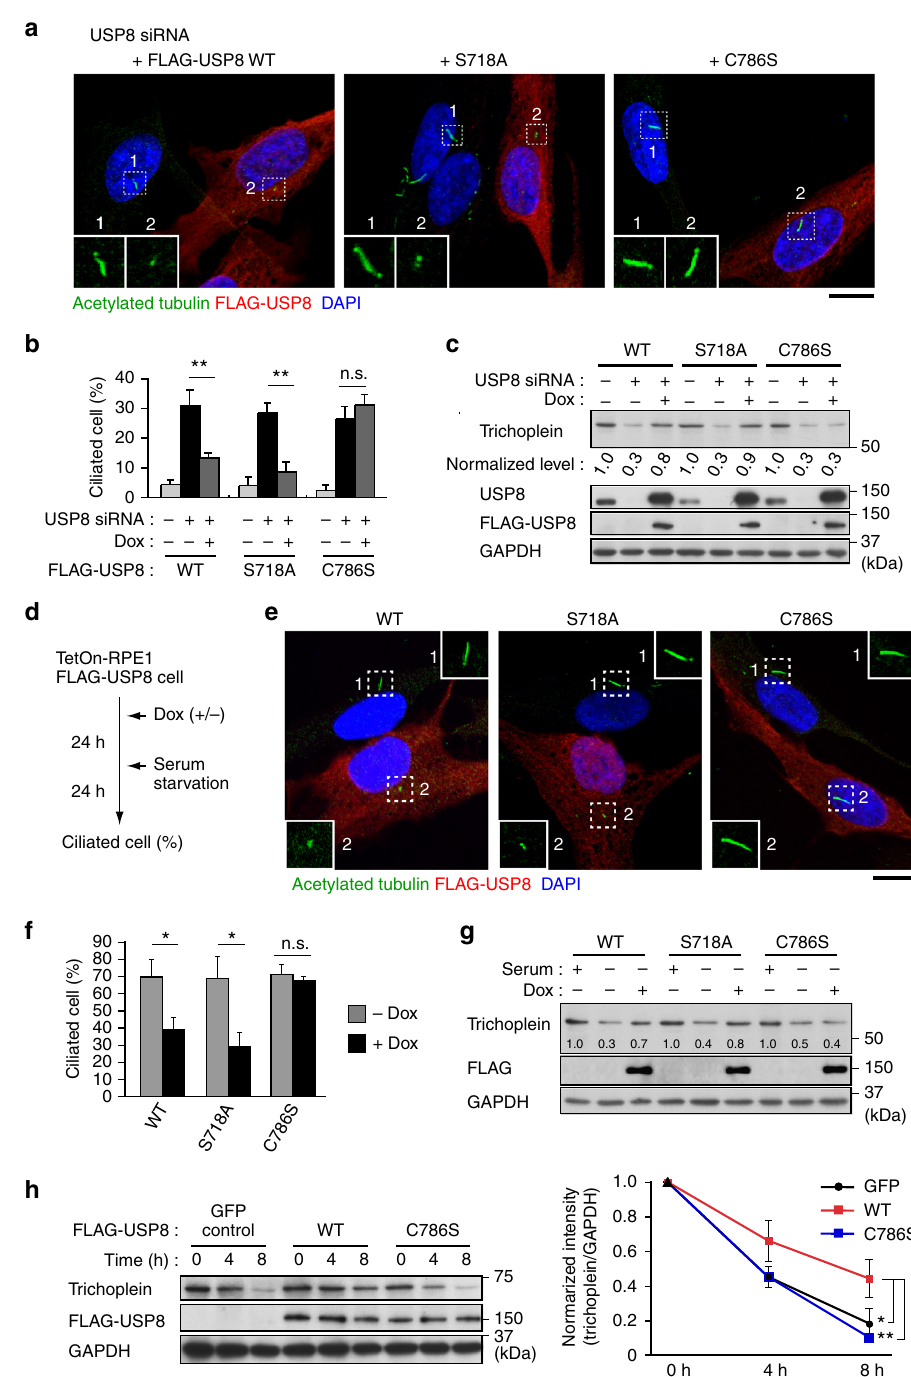
Fig. 2 USP8 activity is essential for suppression of ciliogenesis and stabilization of trichoplein protein. a – c TetOn-RPE1 FLAG-USP8 cell lines (WT, S718A, and C786S) transfected with control or USP8 siRNA (#1) were cultured for 48 h in the presence or absence of doxycycline (Dox, 100 ng ml − 1 ). d – g Expression of FLAG-USP8 (WT, S718A, and C786S) was induced by treatment with Dox (100 ng ml − 1 ), and then subjected to serum starvation as shown in d . Representative confocal images of anti-acetylated-tubulin (green), anti-FLAG (red), and DAPI (blue) are shown in a and e . Insets are magni fi ed images of dashed squares. Scale bars, 10 μ m. Percentages of ciliated cells are shown as mean ± SD from three independent biological replicates ( n > 200 each) in b and f . Immunoblotting analysis of trichoplein, USP8, FLAG and GAPDH are shown in c and g . Normalized intensities of trichoplein/GAPDH are shown as mean from three independent biological replicates. h FLAG-USP8 (WT or C786S) or GFP (as a control) were expressed by treatment with Dox (100 ng ml − 1 ) in TetOn-RPE1 cells, and the cells were treated with 200 nM cycloheximde-supplemented serum-starved medium for indicated times. Normalized intensities of trichoplein/GAPDH are shown as mean ± SD from three independent technical replicates. ** p < 0.01, *0.01 < p < 0.05, n.s. not signi fi cant, two-tailed unpaired student ’ s t